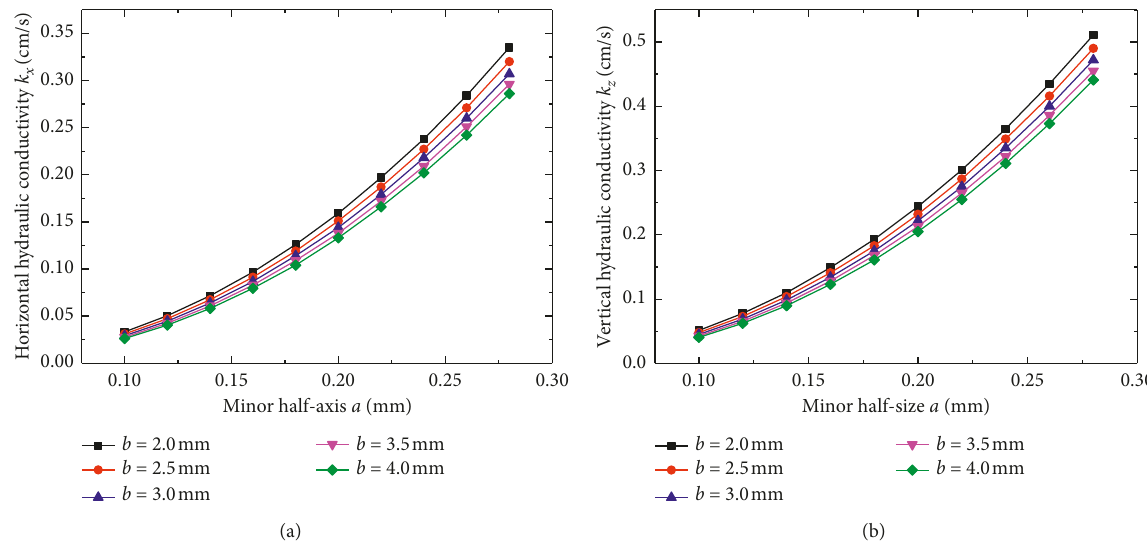
Figure 13: Variation of hydraulic conductivity with particle size under four-particle arrangement. In the same curve, the size of the major axis of the particles is constant, while the size of the minor axis is changing. (a) Horizontal hydraulic conductivity. (b) Vertical hydraulic